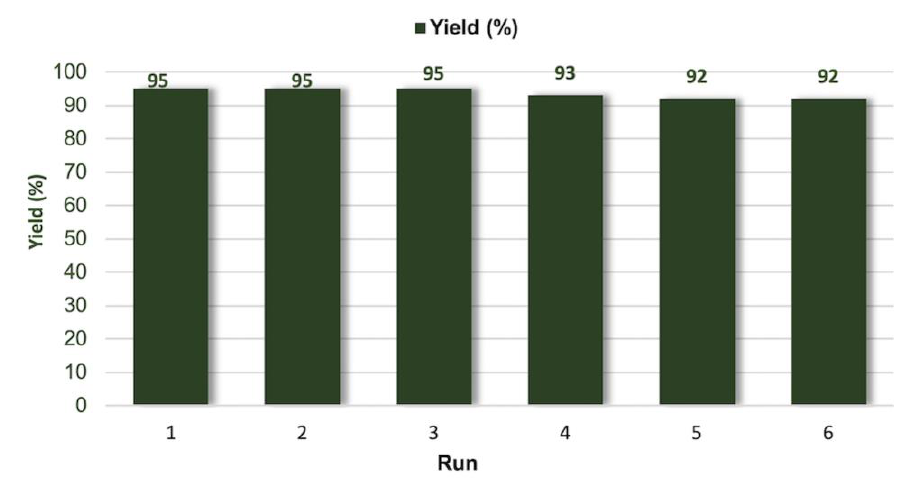
Figure 2. Recycling experiments (optimized conditions of entry 4, Table 3).